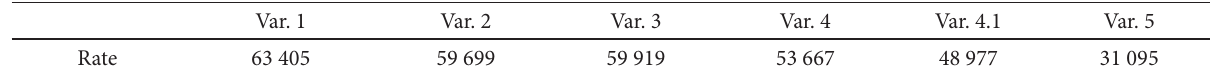
Table 3. Growth rates (thousands EUR per year) – costs of lifespan for each single variant